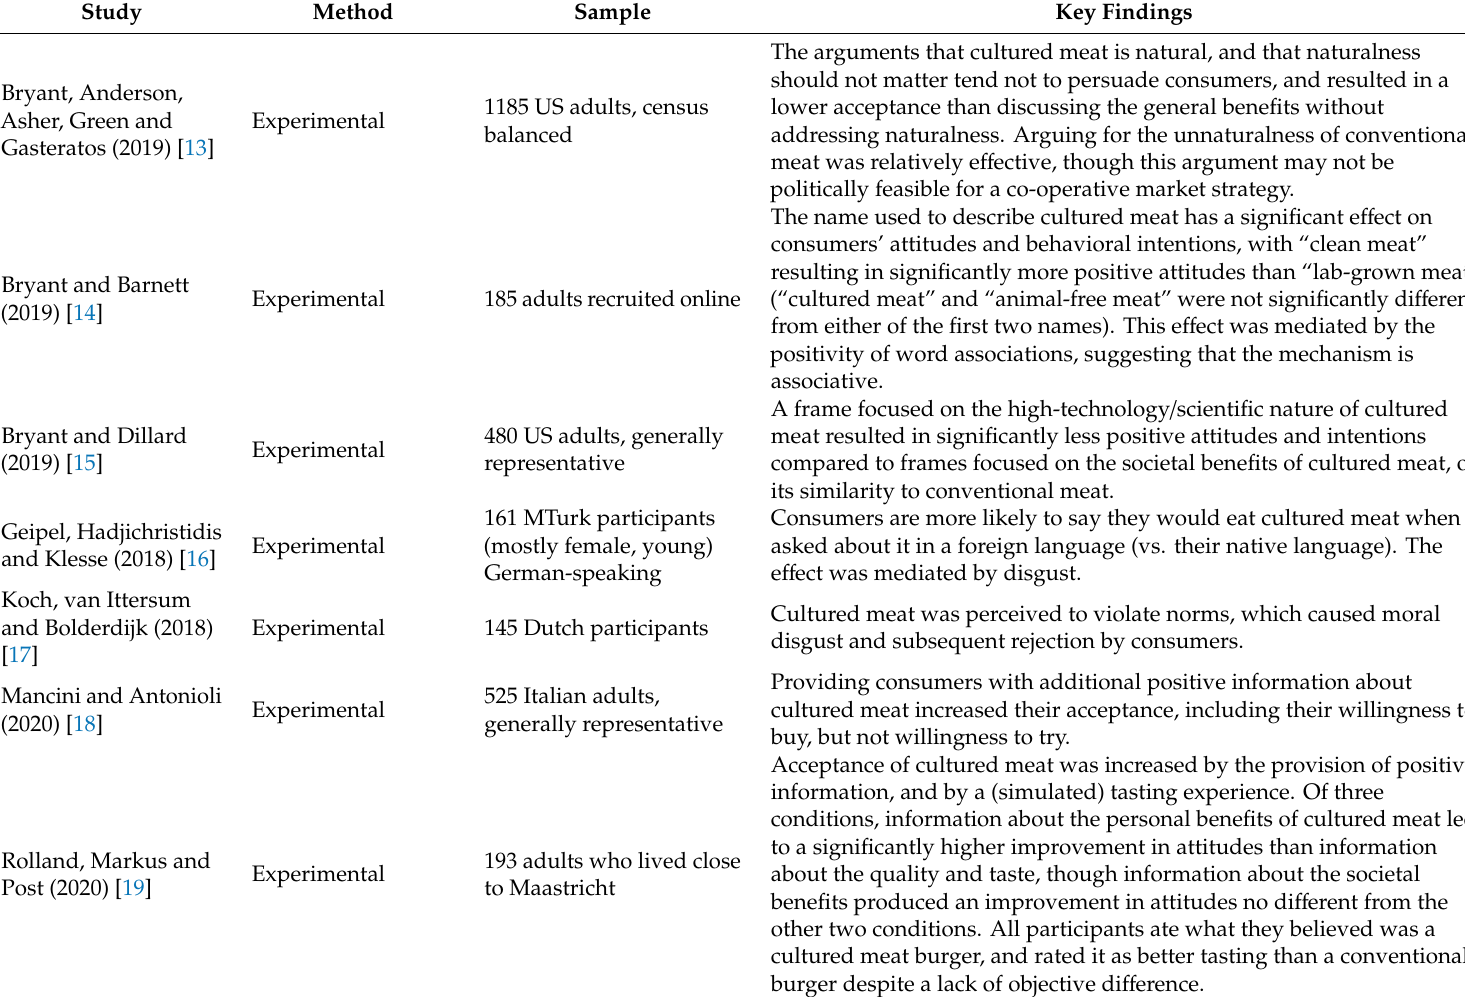
Table 2. Key details of the 26 studies included in the